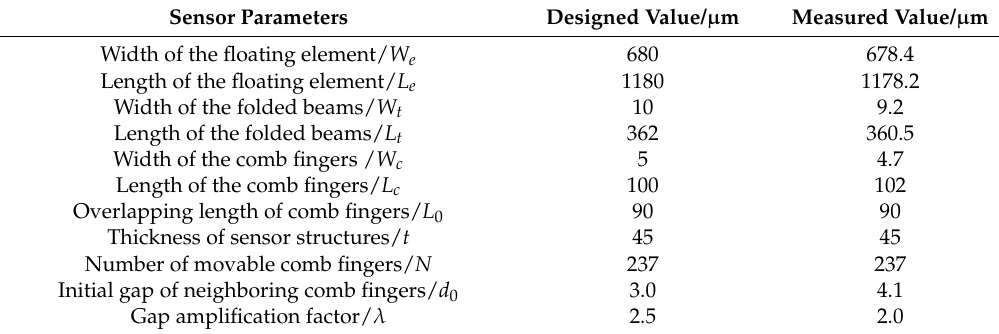
Table 1. Structural parameters of the micro-sensor in this study.